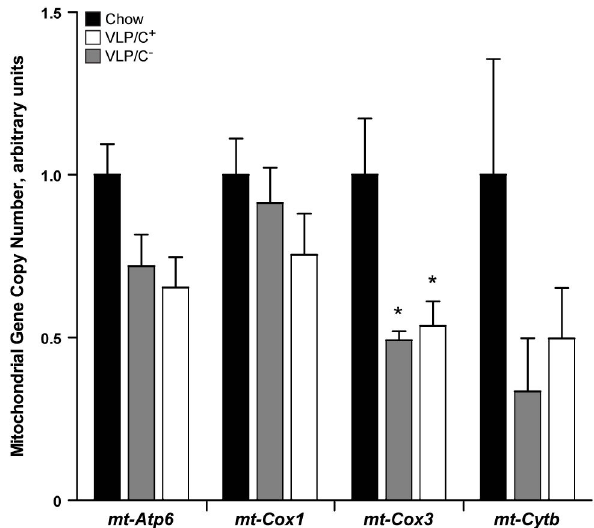
Figure 7. Relative hepatic mitochondrial genome content in mice fed very low protein and carbohydrate, very high fat diets. Quantification of mitochondrial genome copy number (relative abundance) by qPCR using purified liver gDNA from mice maintained on the diets for 6 weeks. Data are presented as means±SEM; n=4-5/group, *p≤0.05 by 1-way ANOVA with Tukey’s post hoc